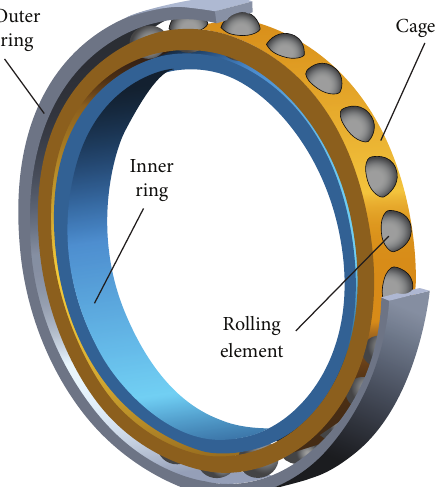
Figure 1: The structure of ceramic ball bearing.